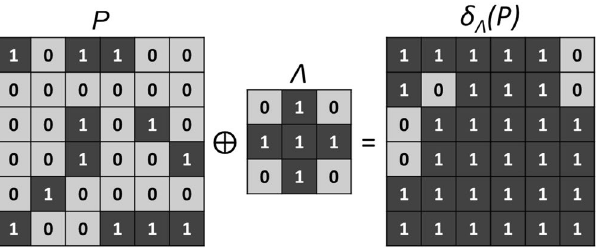
Figure 3. Morphological dilation operated with a cross structuring element (cid:31) on the matrix P .